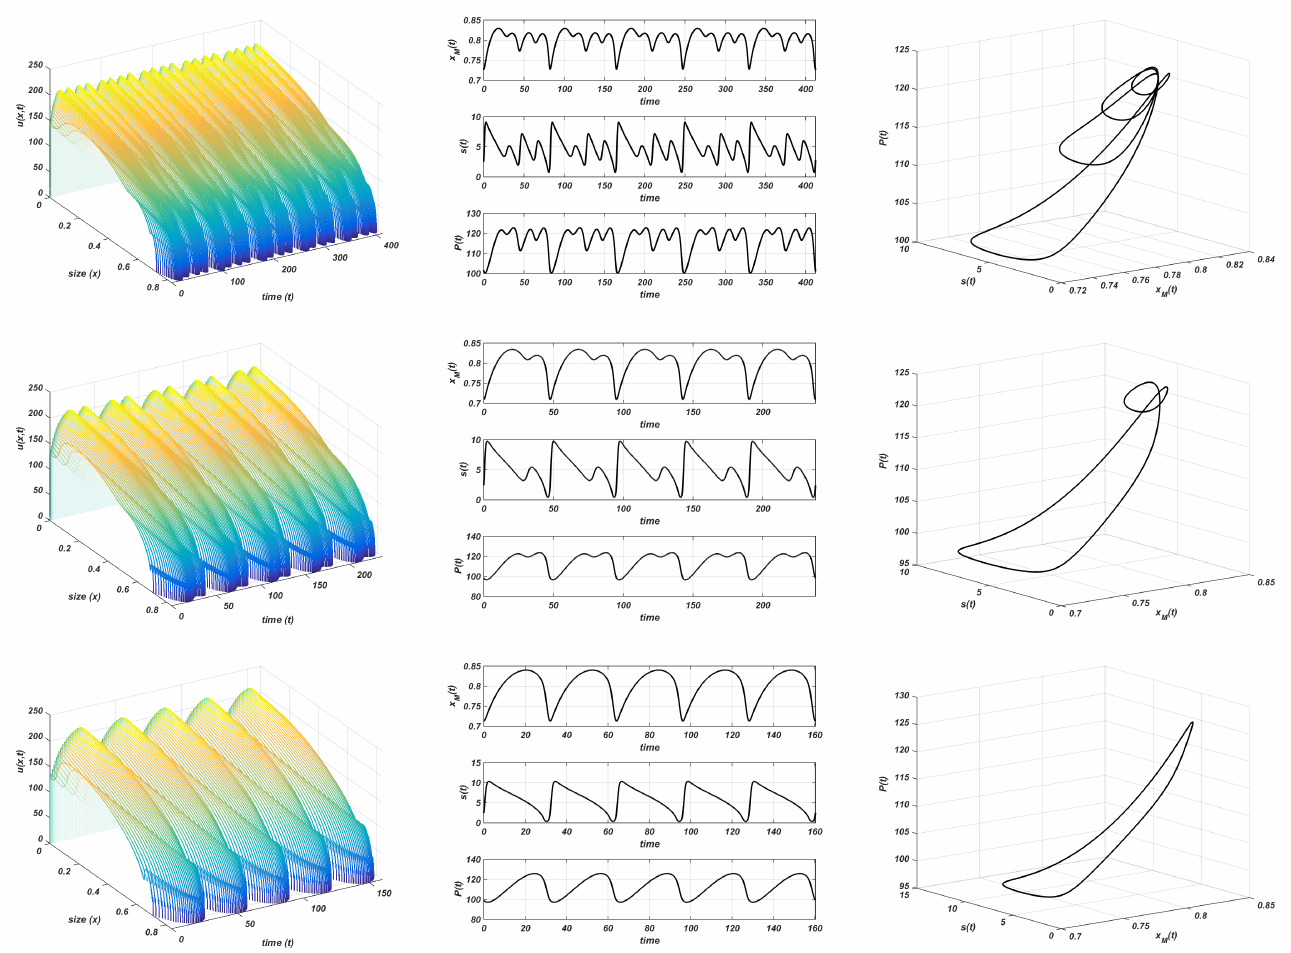
Figure 9. Gompertz growth. r = 3. Stable limit cycle. Plot on the left : evolution of the structure of the consumer; plot in the centre : evolution of the maximum size, resource, and total consumer population to the equilibrium; plot on the right : stable limit cycle. Values of K from top to bottom: K = 15.21, K = 15.33, K = 15.45, and K = 15.93.